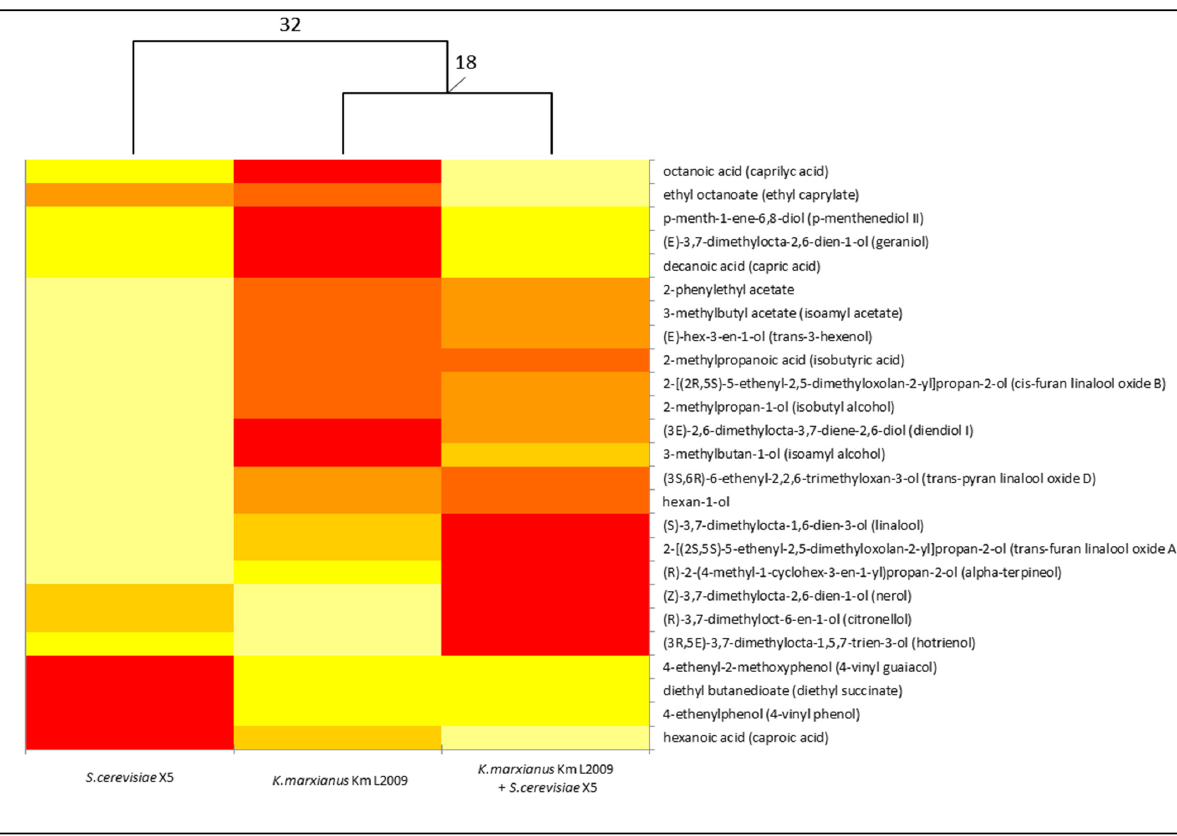
Figure 3. VOCs distribution among different fermentations. The dendrogram is based only on VOCs of Table 3 showing concentrations with statistically significant differences. The heat map plot depicts the relative quantity of each VOC (variables clustering on the X-axis) within each type of fermentation (Y-axis clustering). The values for VOC concentrations are depicted by color intensity from light yellow (lowest concentration) to red (highest concentration). Numbers indicate the distances between the clustered columns calculated as Euclidean distances.